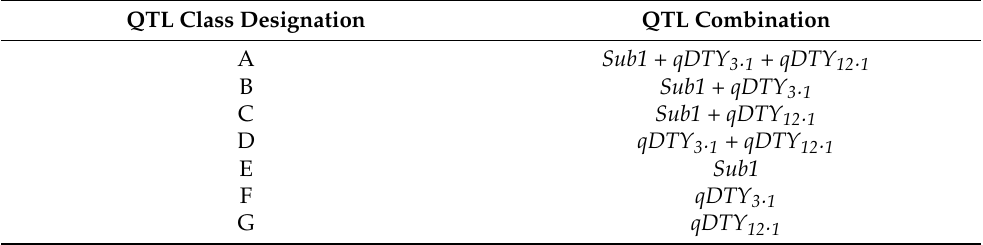
Table 6. Possible QTL classes for UKM5*/IR64- Sub1 population in NS, RS and vs.